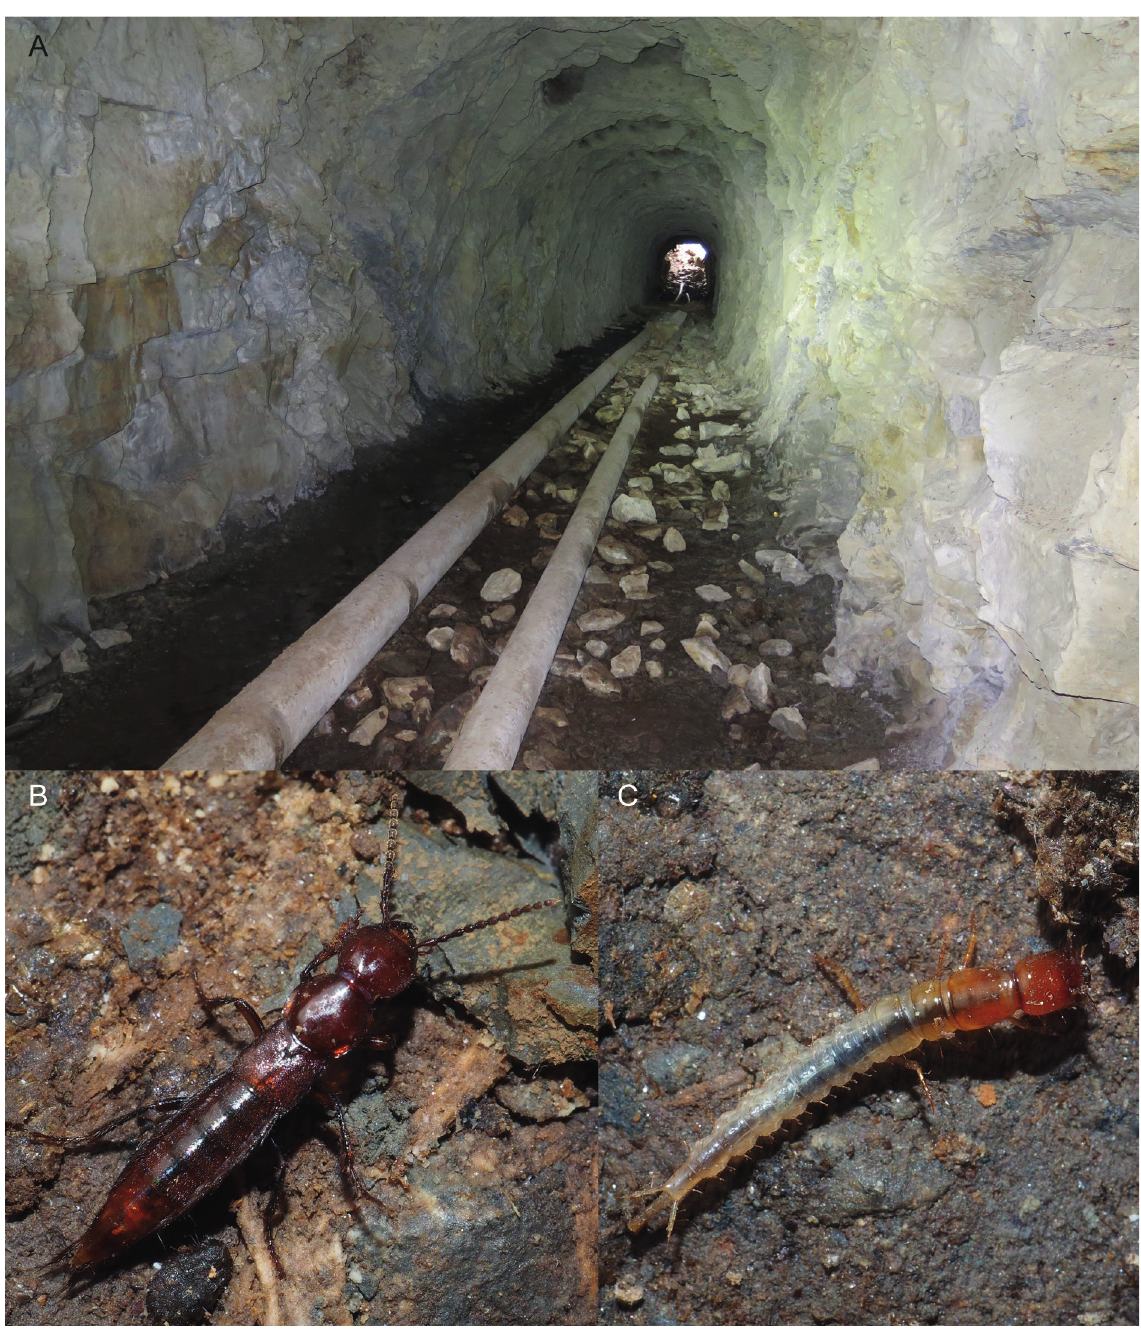
Fig. 9. Photographs of collection site and live specimens of Quedius masuzoi Watanabe, 1989. A . Habitat of newly collected specimens reported in this paper. B . Adult. C .